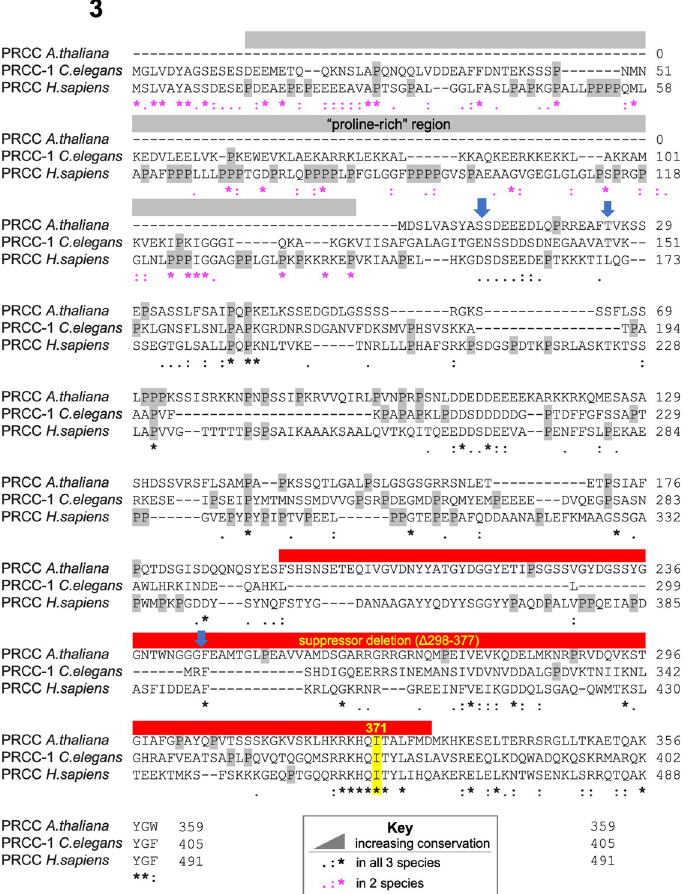
Fig 3. Both suppressor mutations overlap with the longest stretch of identity in PRCC. Multiple sequence alignment of PRCC-1 and orthologs. The “proline-rich” region frequently observed in human oncogenic fusions is indicated in gray, and all prolines are highlighted in gray, the suppressor mutation I371 is highlighted in yellow, the suppressor deletion ( Δ 289–377) is indicated in red. Sequence conservation is annotated as described in the key. PRCC (null) is not represented because it is a deletion of all coding regions of the gene. Vertical blue arrows mark the commonest breakpoints for PRCC N-terminal oncogenic fusions [74]. Alignment generated in Clustal Omega